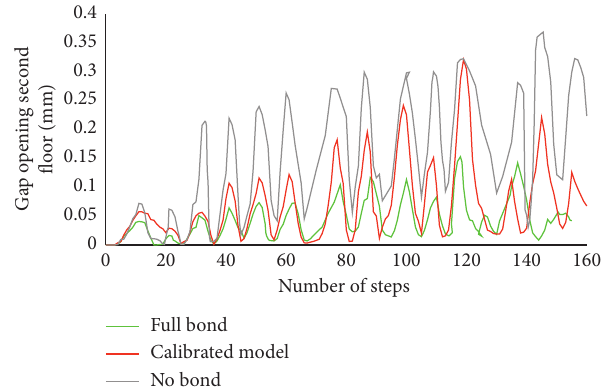
Figure 13: Comparison of the results in terms of gap opening between the numerical model results considering full bond, no bond, and calibrated model